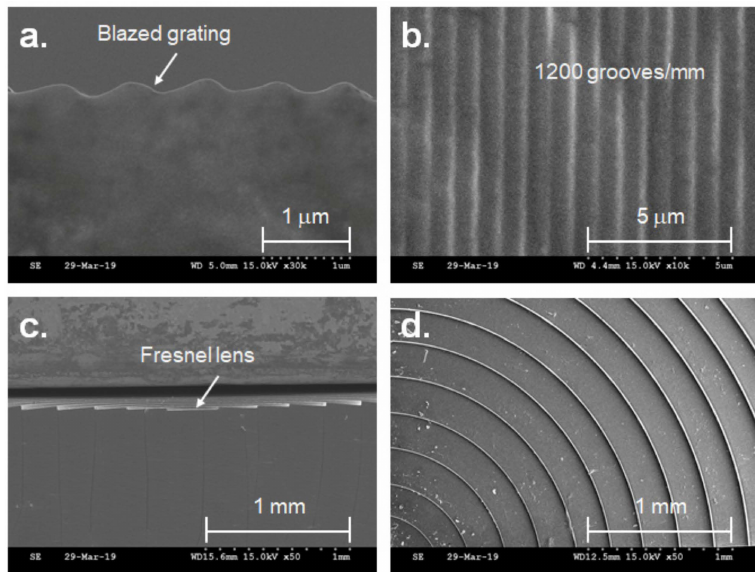
Figure 3. Microscopic scanning electron microscopy (SEM) image of the G-Fresnel optical device. ( a ) Cross section of grating, ( b ) top view of grating, ( c ) cross section of Fresnel, ( d ) top view of G-Fresnel.